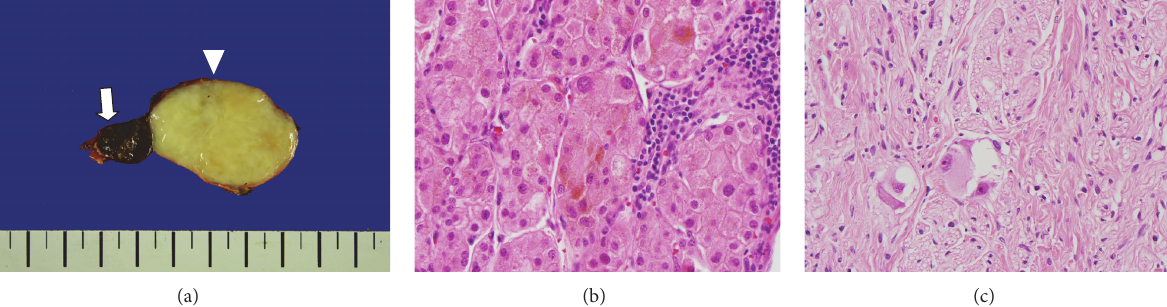
Figure 2: Histological findings of the patient. (a) The gross specimen shows a 2 cm dark-brownish mass (arrow) and a 4.5 cm whitish solid mass (arrowhead) within the adrenal cortex. (b) The 2 cm mass showed abundant eosinophilic, granular cytoplasm with variable sized brown pigments (40x). (c) The 4.5 cm mass showed fascicles of Schwann-like cells and some clusters of ganglion cells